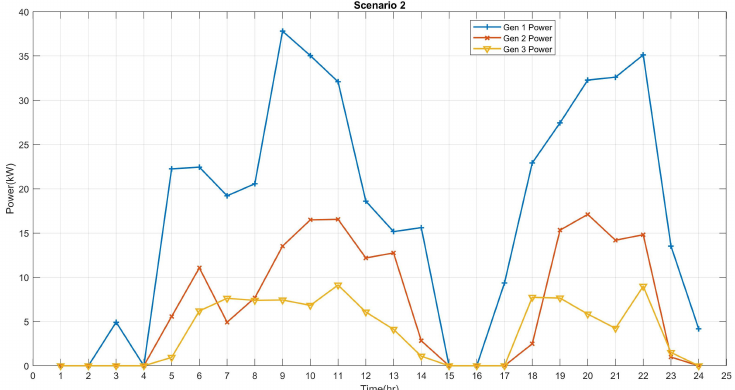
Figure 6. Power dispatched by the microgrid in Scenario 2.